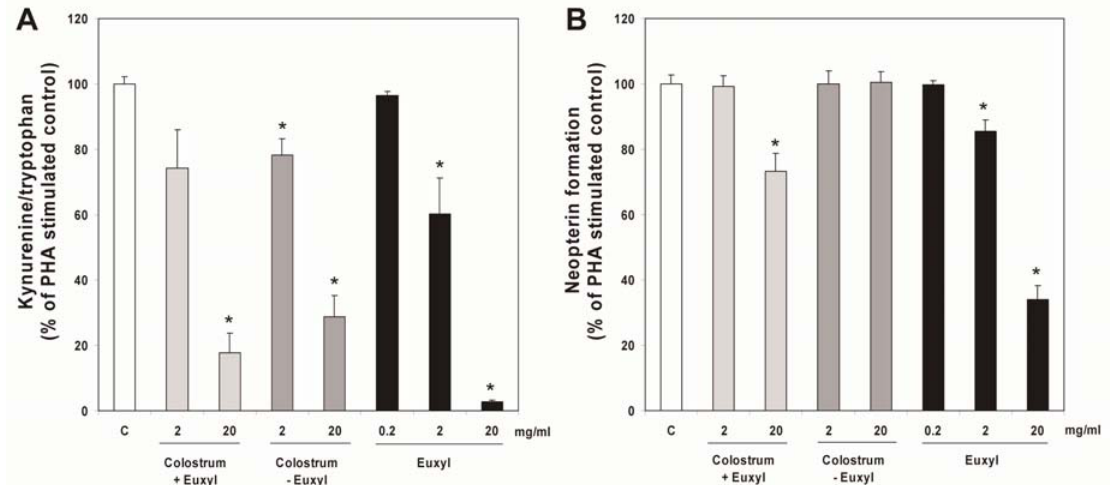
Figure 3 : Kynurenine to tryptophan ratio (left) and neopterin formation (right) expressed as % of human periph- eral blood mononuclear cells stimulated with 10 µ g/ml phytohaemagglutinin and treated or not with increasing concentrations of bovine colostrum nanoparticles containing hyaluronic acid with or without preservative euxyl and euxyl alone for 48h. Results shown are the mean values ± S.E.M. of three independent experiments run in duplicates (*p <